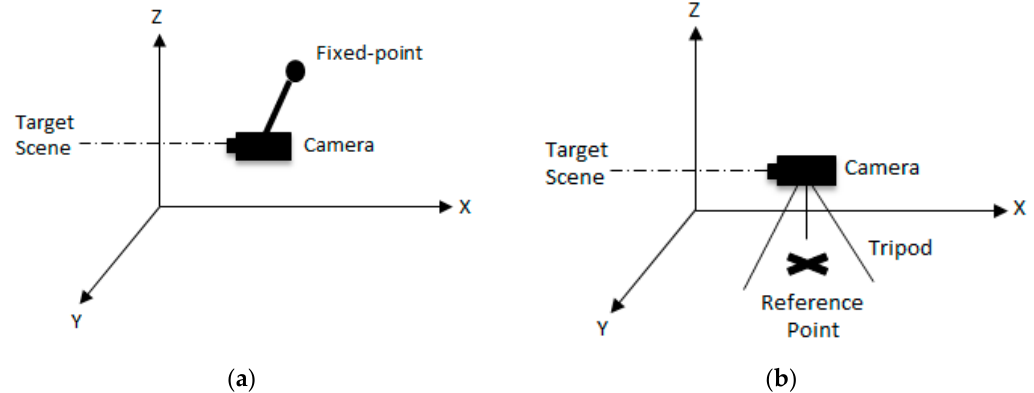
Figure 5. Holding a camera in a single position and orientation on a jobsite. ( a ) Using a fixed-point camera for each scene on a jobsite; ( b ) Embedding a benchmark (point of reference) for each scene on a jobsite.